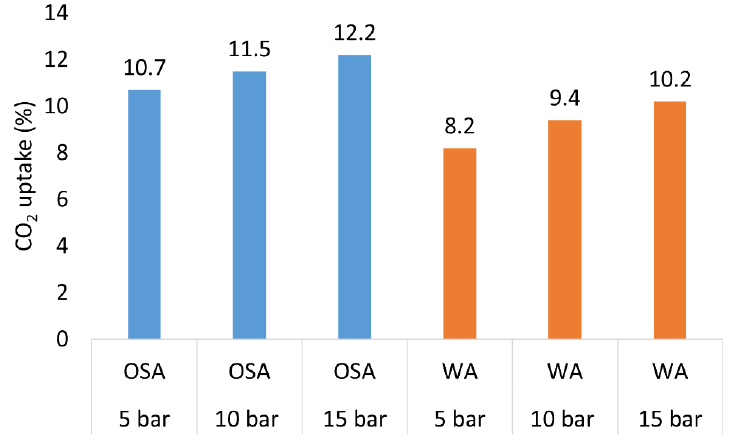
Figure 8. CO 2 uptake values at different curing pressures (100% CO 2 , 25 °C, 150 kg/cm 2 ) (Average values obtained from min. 4 samples (std. deviation < 3%)).